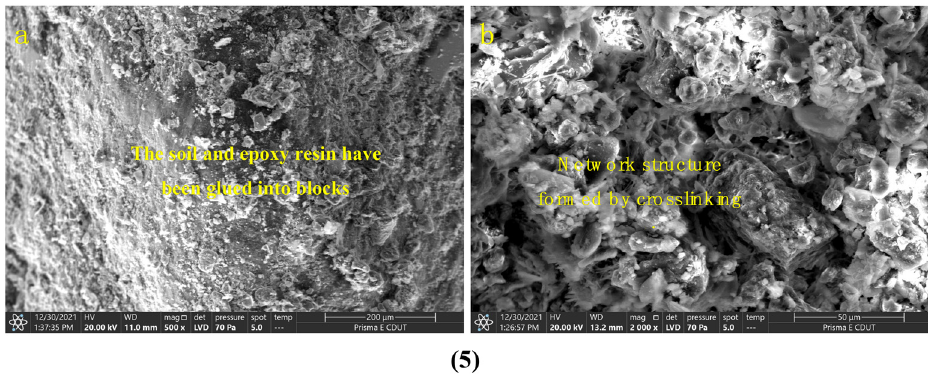
Figure 20: SEM images of specimens with di ff erent materials: ( 1 ) SEM of pure yellow mud; ( 2 ) SEM of straw - improved yellow mud; ( 3 ) SEM of starch - modi fi ed yellow mud; ( 4 ) SEM of cement - modi fi ed yellow mud; and ( 5 ) SEM of epoxy resin - modi fi ed